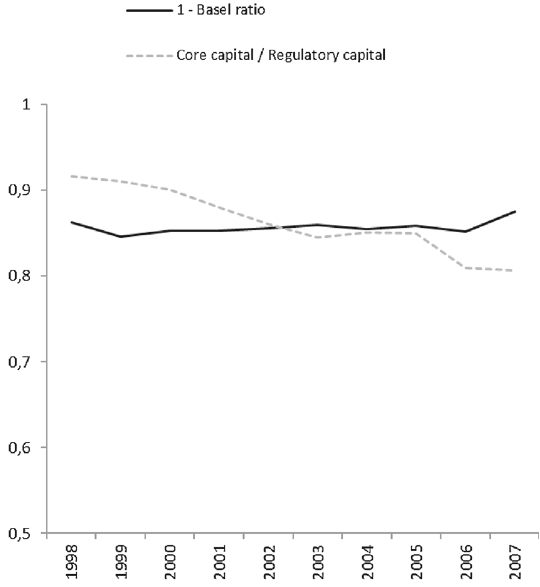
Fig. 3 Basel ratio and composition of regulatory capital. Average across